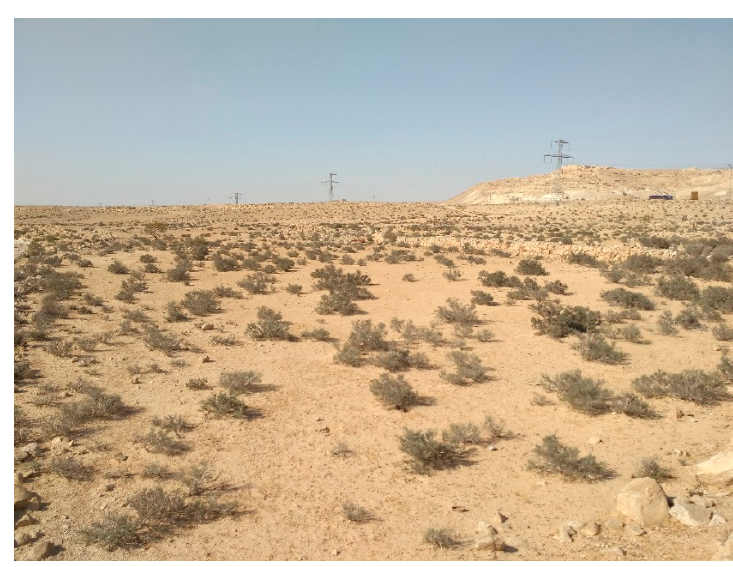
Figure 2. An intact-terrace plot; downslope view. Photo taken by E. Groner, on summer 2017.